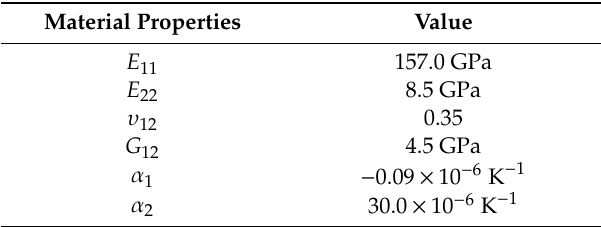
Table 1. Material properties of M21 / T800 prepreg sheet data from